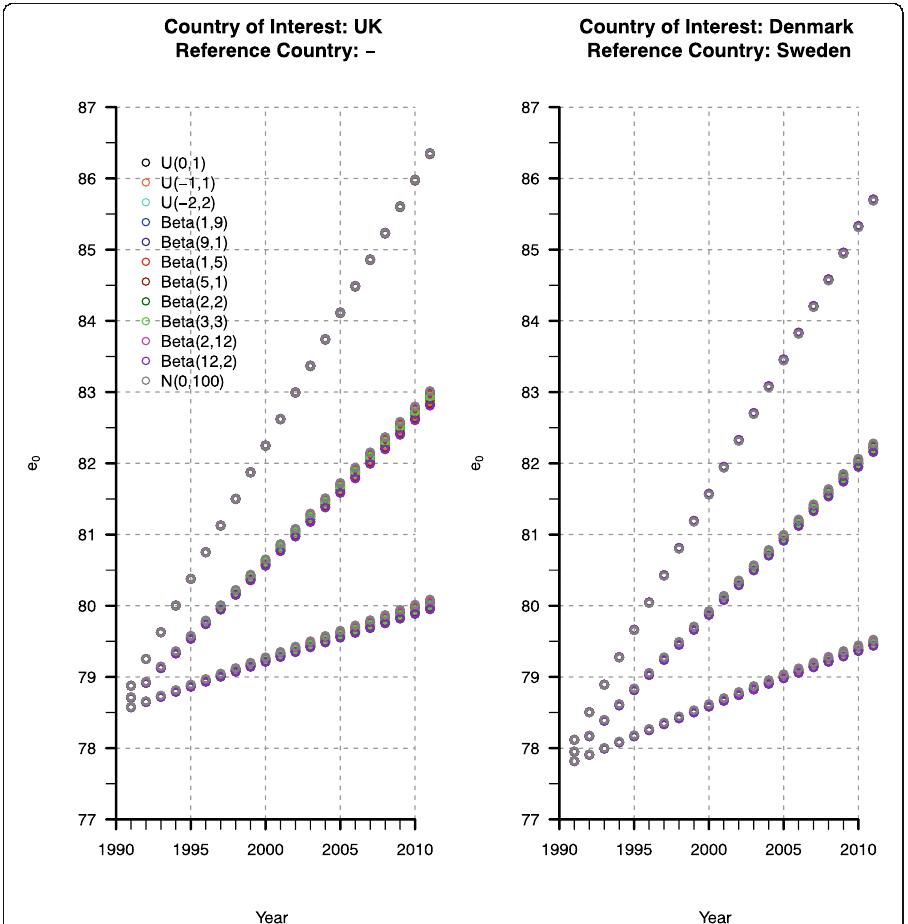
Fig. 17 Prior sensitivity analysis: the validating forecasts (represented by the median and the 80% prediction intervals) of British ( left ) and Danish ( right ) life expectancy are (very) similar, although we use different prior specifications (differently colored circles ) for our